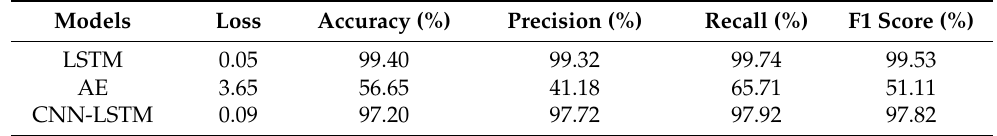
Table 9. Results of the deep learning models using the Drebin